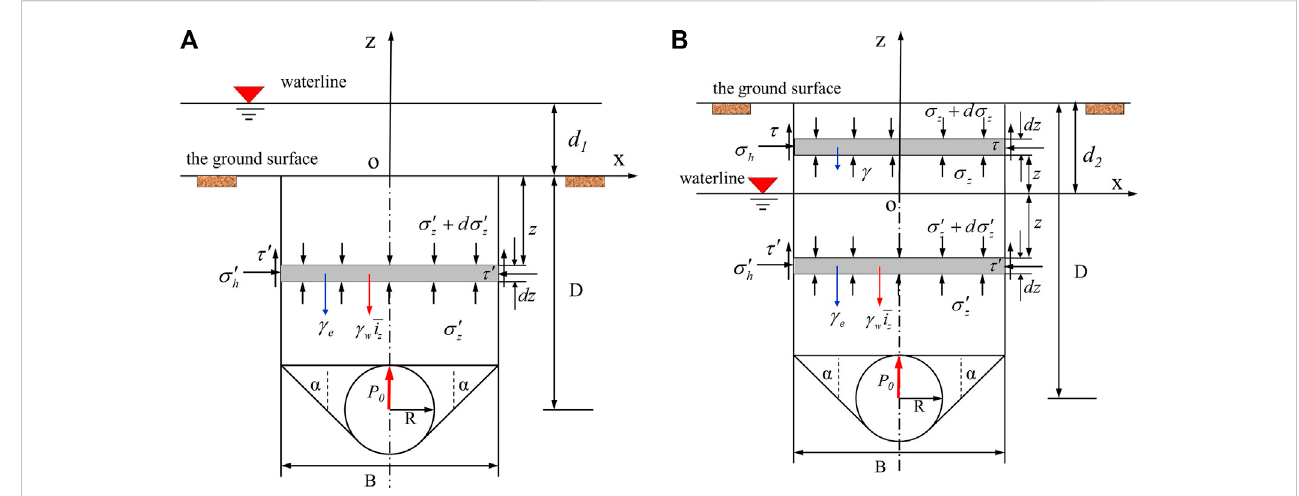
FIGURE 2 Analysis model of water and soil load on the top of a marine shield tunnel. (A) marine segment, (B) terrestrial segment.